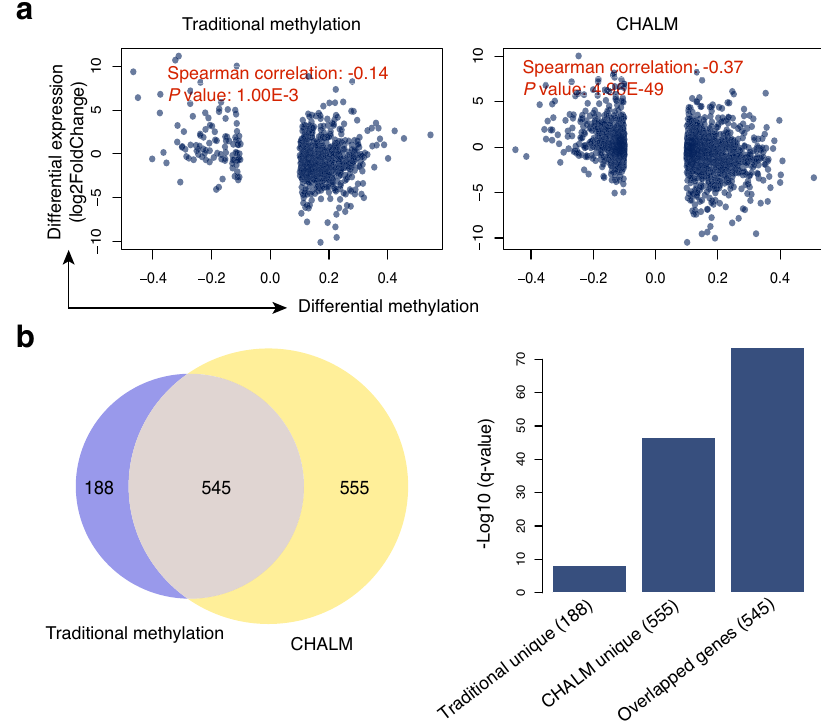
Fig. 4 CHALM better identi fi es hypermethylated promoter CGIs during tumorigenesis. a Scatter plots show the correlation between differential expression and differential methylation calculated by the traditional and CHALM methods. All promoter CGIs were included for analysis, but only those exhibiting a signi fi cant methylation change between normal and cancerous lung tissue were plotted. X -axis: differential methylation ratio; y -axis: differential expression (log2FoldChange). Comparison of correlation (between the traditional method and CHALM) permutation P values: <1 × 10 − 4 . b A large fraction of hypermethylated promoter CGIs identi fi ed by the traditional method can be recovered using the CHALM method, as indicated by the Venn diagram. Bar plot shows enrichment of the H3K27me3 peak in three different gene